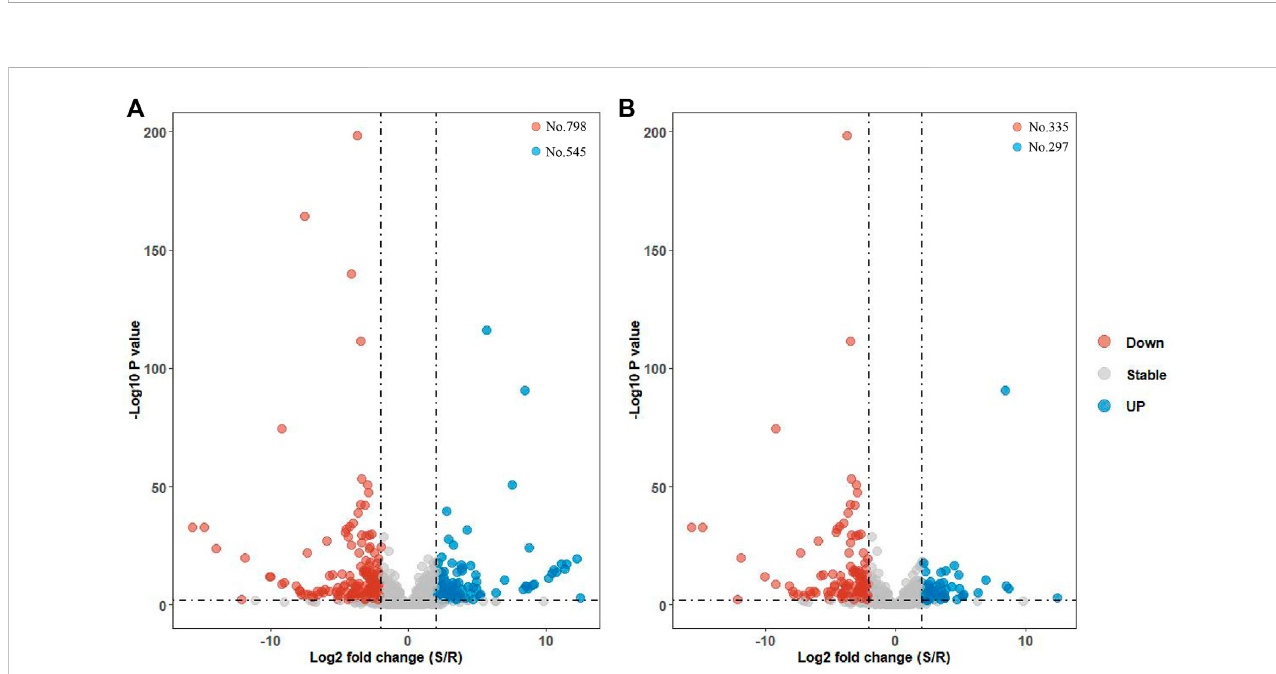
FIGURE 3 Volcano map of differentially expressed lncRNA genes. (A) Expression pro fi le of all 1,343 dysregulated lncRNAs in S and R strains were plotted via the volcano map. (B) Expression pro fi le of 632 DE lncRNAs in S and R strains. They met a strict screening criteria, that is, |log2 fold-change| > 1, p -value < 01, and p -adj <